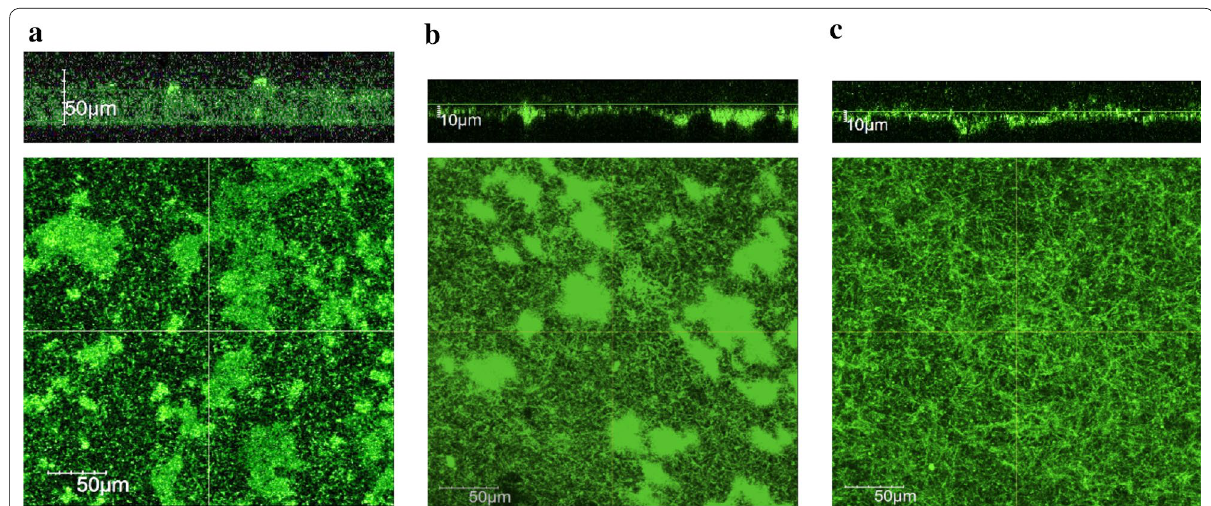
Fig. 3 Structures of live biofilms formed on graphite plates under aerobic ( a ) and electricity-generating ( b , c ) conditions by GFP-expressing S. oneidensis MR-1 in the presence of medium flow. For current generation, potentials of graphite-plate electrodes were poised at 0 V ( b ) and ( c ) vs. Ag/AgCl reference electrodes. Top images are XZ projections, while bottom images are XY